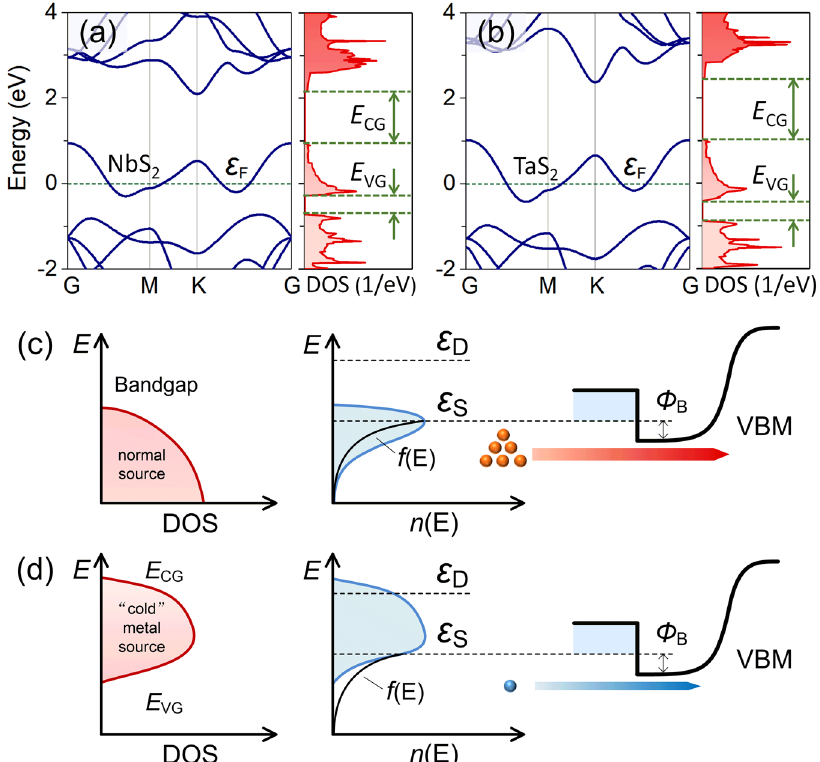
Fig. 1 Band structures, DOS and switching mechanism of ‘ cold ’ metals. a , b Band structures of monolayer metallic 2H MS 2 (M = Nb, Ta). The green dash lines in band structures represent the Fermi level. The energy gaps in the conduction band ( E CG ) and valence band ( E VG ) are labelled. c , d The schematic DOS, carrier density ( n (E)) and energy band diagrams of the ( c ) conventional MOSFET and ( d ) CM-FET. ε S and ε D represent the Fermi level of source and drain, respectively. Φ B is the channel barrier height. The width of arrows represents the magnitude of currents, and the number of balls represent the carrier density for transmission. The black curves in n (E) represent the Fermi-Dirac